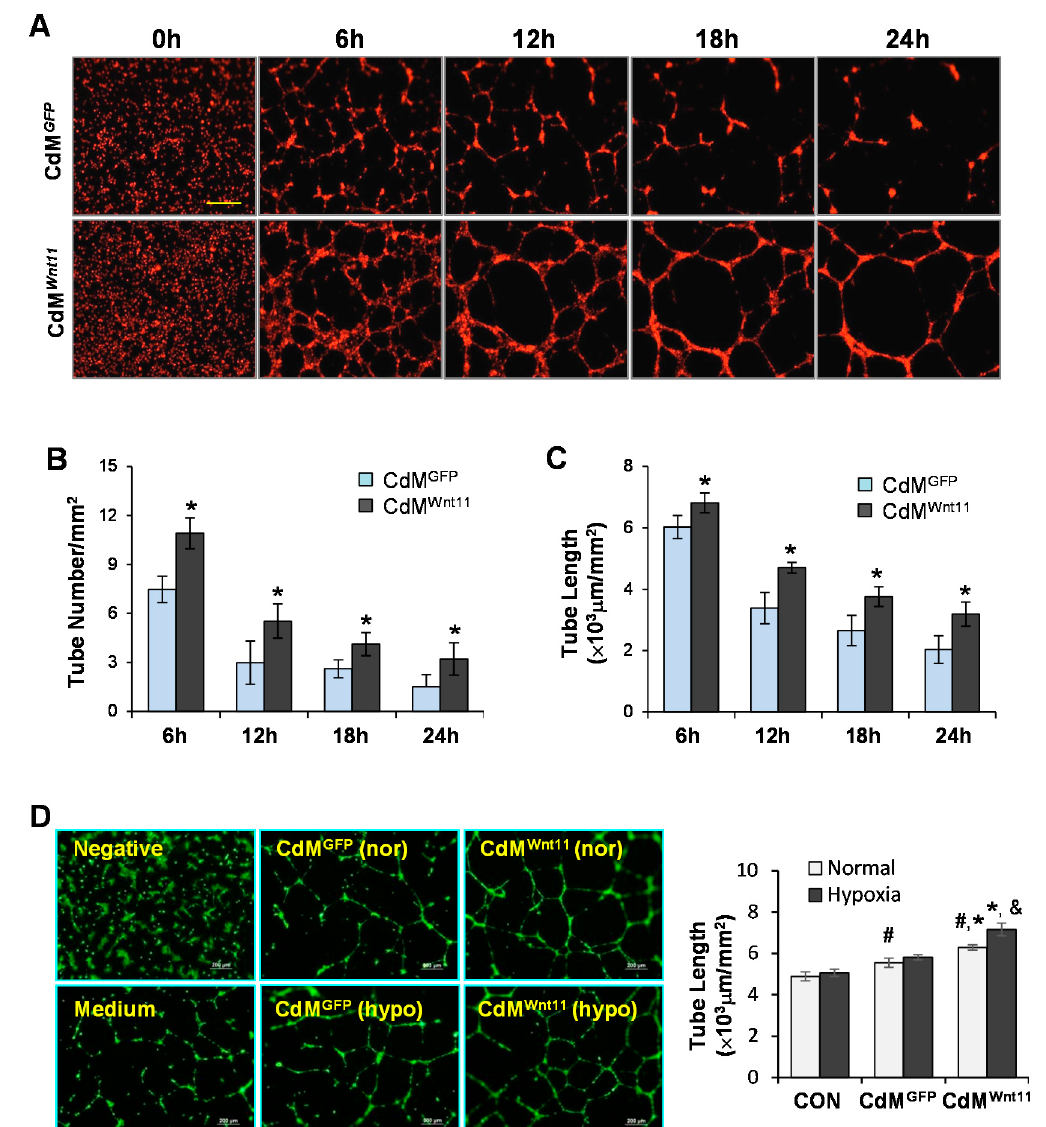
Figure 2. CdM Wnt11 significantly promote capillary-like tube (CLT) formation. ( A ): Representative real-time images of CLT formation following human umbilical vein endothelial cell (HUVEC) treatment with CdM Wnt11 and CdM GFP . The scale bars represent 800 μ m. ( B , C ): Quantitative analysis of the tube number and length. ( D ): CLT formation of HUVECs treated with various CdM collected from MSCs exposed to normal or hypoxia. # , p < 0.05 vs. CON; *, p < 0.05 vs. CdM GFP ; & , p < 0.05 vs. CdM obtained from MSCs exposed to normal culture, respectively.